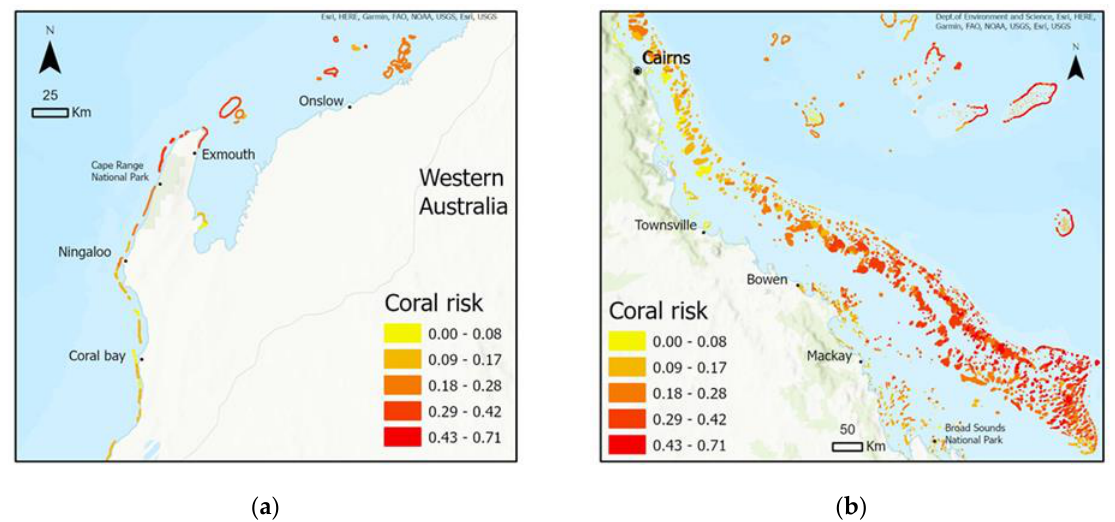
Figure 13. Tropical Cyclone risk to corals in the Ningaloo Reef ( a ) and the southern Great Barrier Reef ( b ). Higher (red) values denote higher risk.